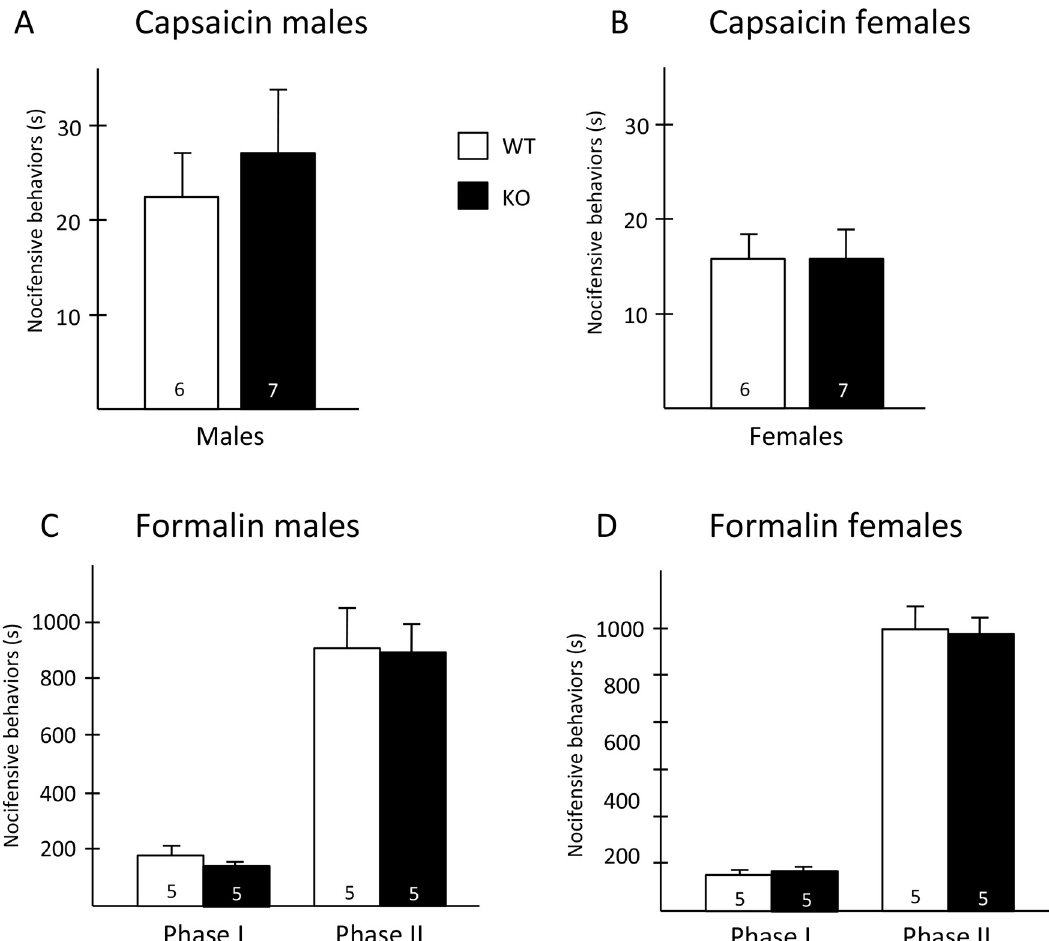
Fig 3. Chemical pain responsiveness of Hippocalcin-like 4 mutant mice. Nocifensive behaviors (licking/flinching) in response to hindpaw injection of capsaicin (A-B) or formalin (C-D) were similar in WT and Hpcal4 mutant mice. Data are presented as mean ± SEM. Statistical significance was determined by Student’s